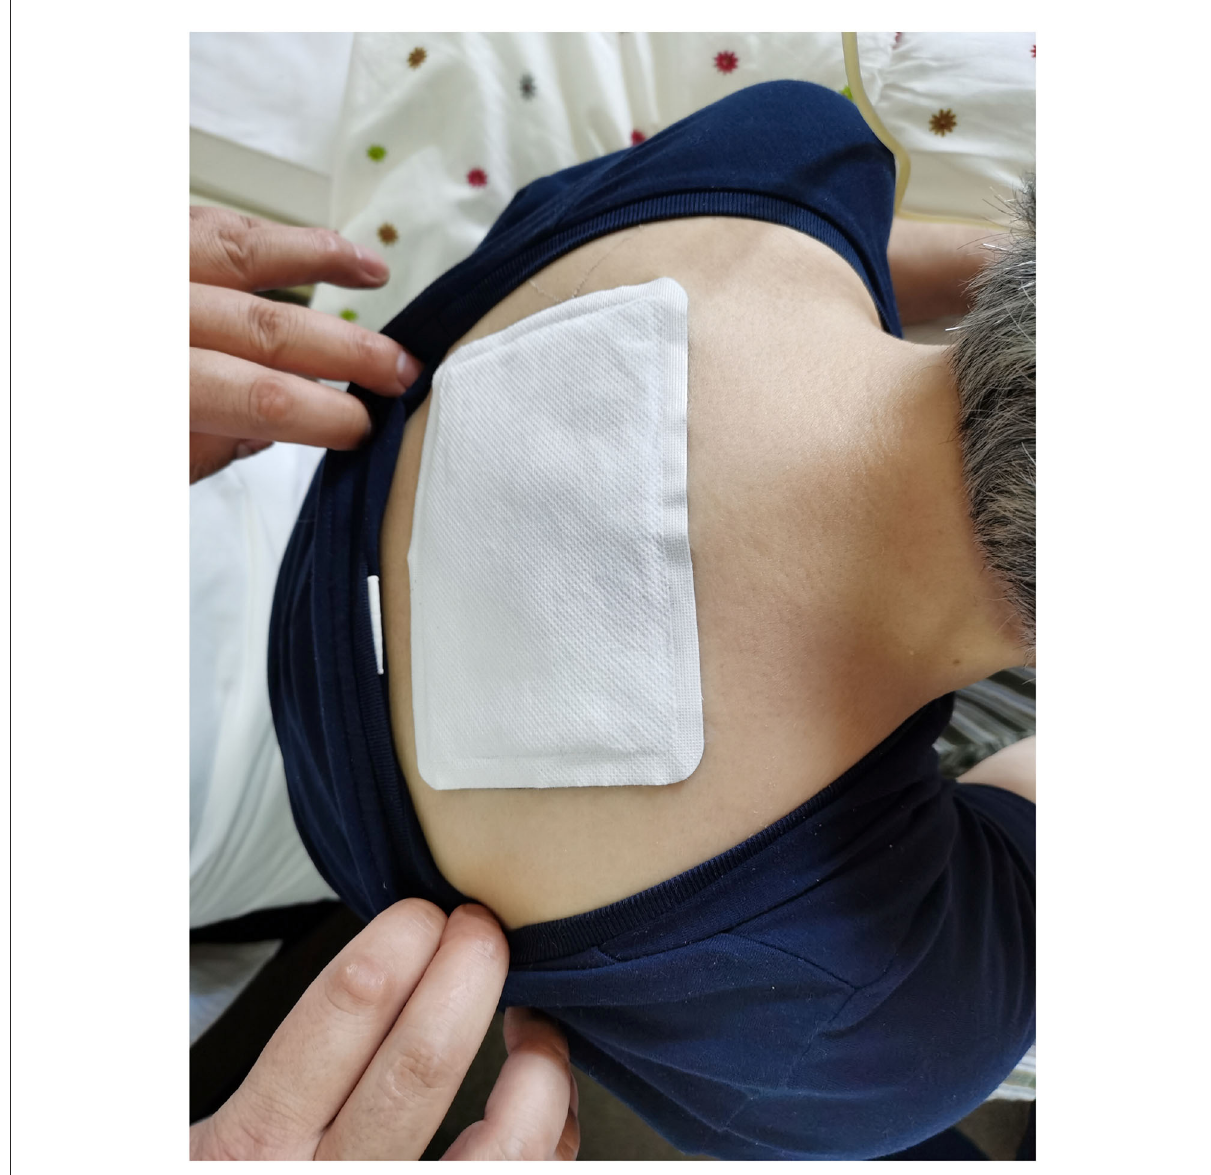
FIGURE2 Positioning of the JWLP and the PLAP in an ALS